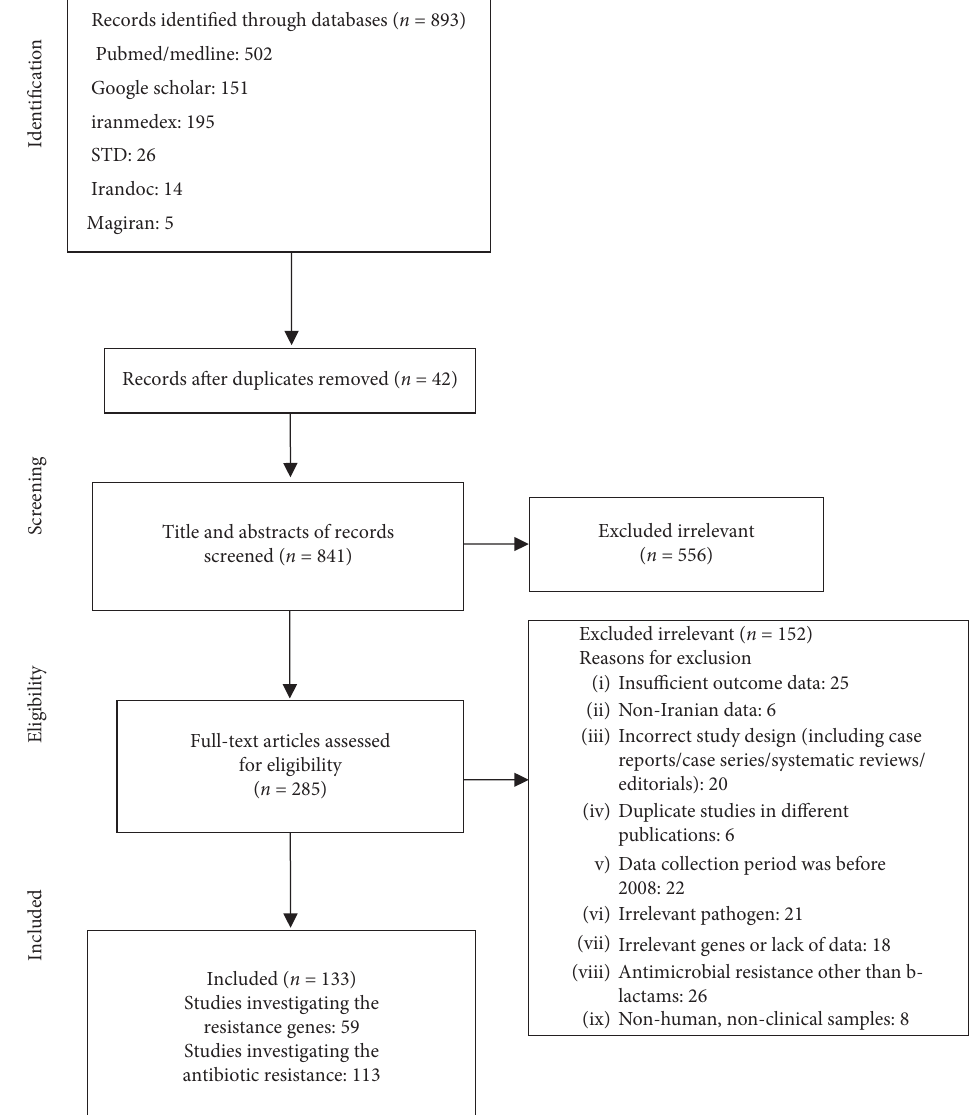
Figure 1: Flow chart of study selection for inclusion in the systematic review and meta-analysis. Table 1: The percentage of antimicrobial resistance. Percent of articles reporting high Antibiotics